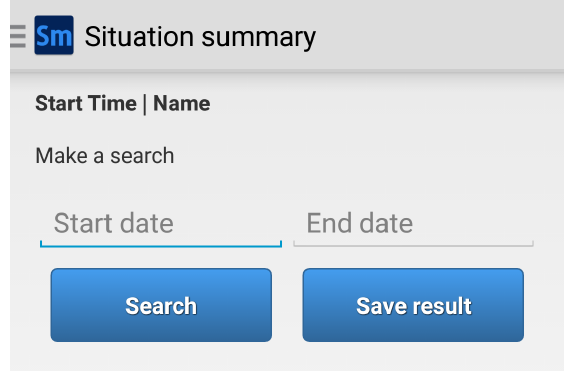
Figure 6. SituMan Mobile GUI of the Situations